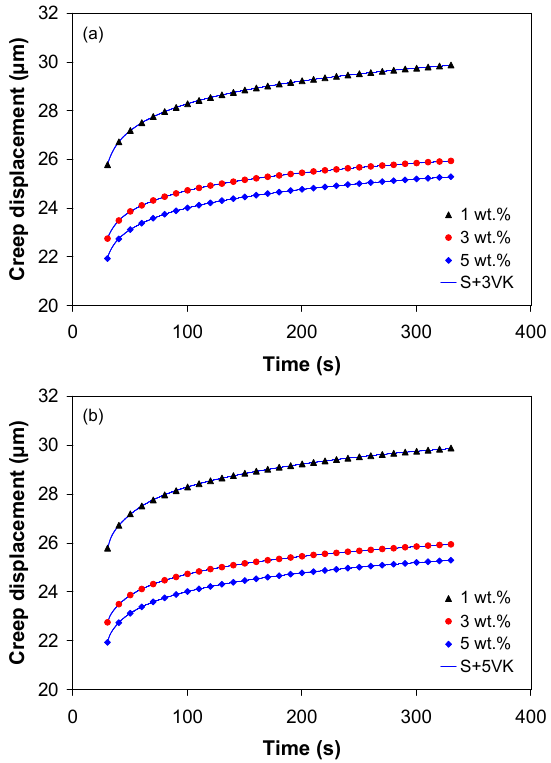
Figure 9. Comparison between experimental creep displacement and prediction based on the S + nVK model with ( a ) three VK units and ( b ) five VK units (predictions are shown as solid lines).